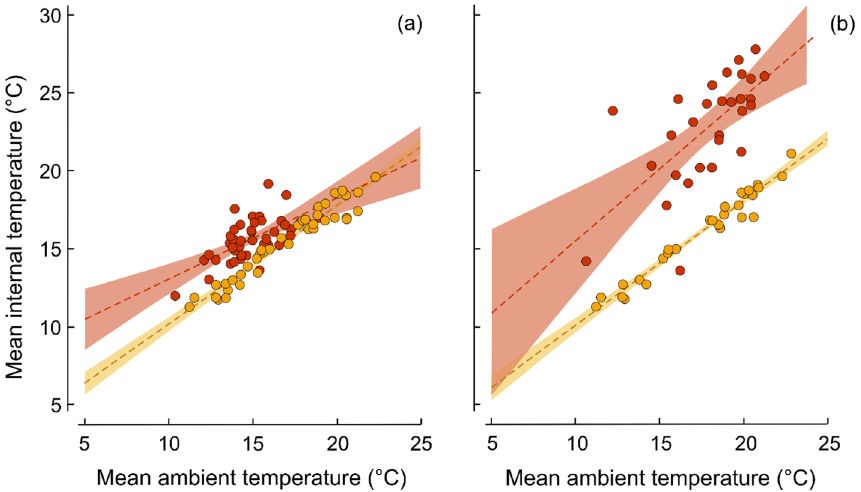
Figure 1. The relationship between mean daily ambient and internal temperatures in active (red circle) wood warbler Phylloscopus sibilatrix nests and in the same nests when vacant (yellow circle), recorded in 2017–2019 in the Białowieża National Park (Poland). Active nests contained incubated eggs ( a ; n = 44 nests), or nestlings of a median 7 days old ( b ; n = 29 nests). Dashed lines show trends and shaded areas are 95% confidence